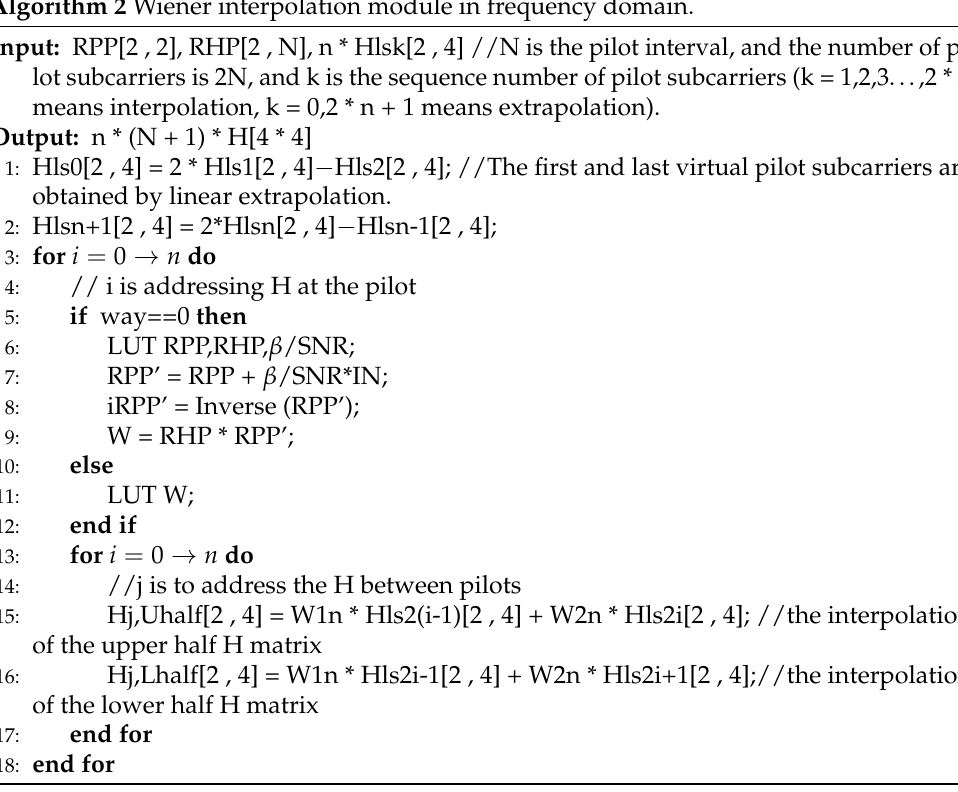
Algorithm 2 Wiener interpolation module in frequency